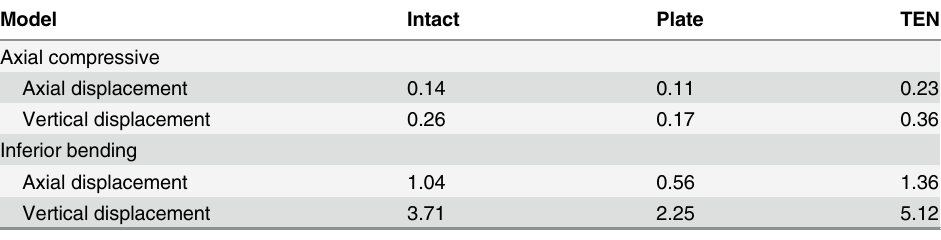
Table 2. Average axial and vertical displacements of the 15-mm most distal part of each model